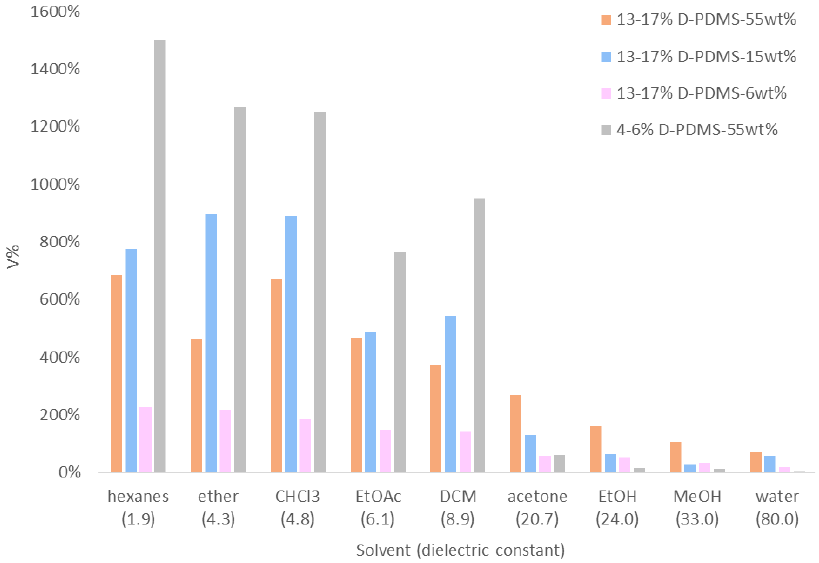
Figure 8. Percent increases of D-PDMS volume (V%) in various solvents. Note: the dielectric constants ( ε ) of the solvents increase from left to right; values are provided in parentheses under each solvent name.